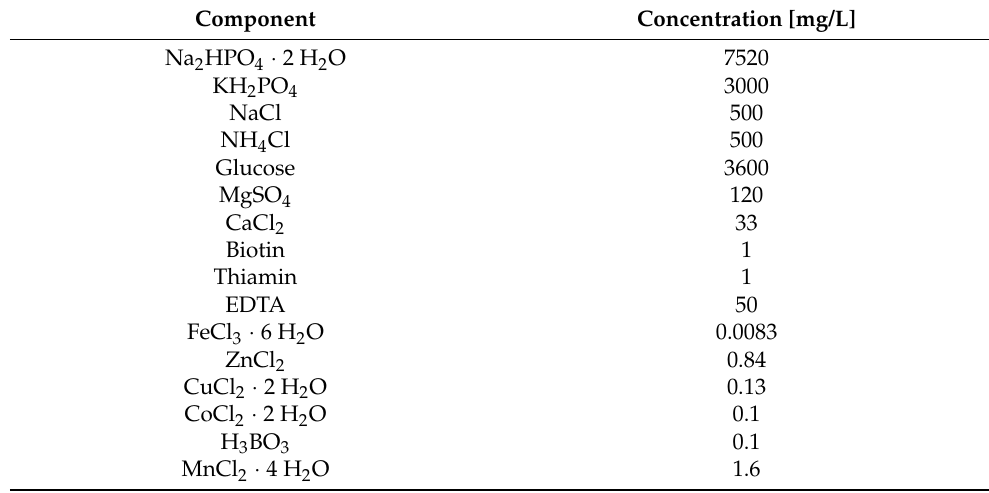
Table A1. Components and their concentrations in M9 minimal medium (all purchased from Carl Roth, Karlsruhe,